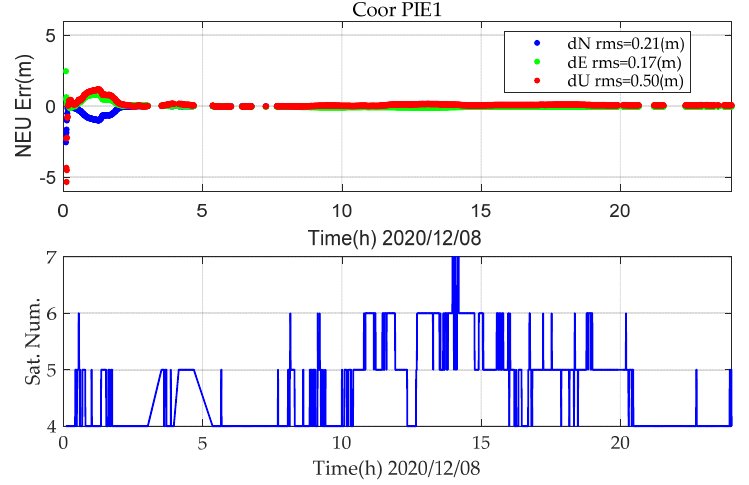
Figure 3. BDS (B1IB3I) static PPP positioning error and number of satellite (DOY343, 2020). For kinematic PPP, the number of satellites has a very large impact on positioning. When the number of satellites is less than five, abnormal jumps occur, as shown in Figure 4. Therefore, in the subsequent data analysis, the above cases are